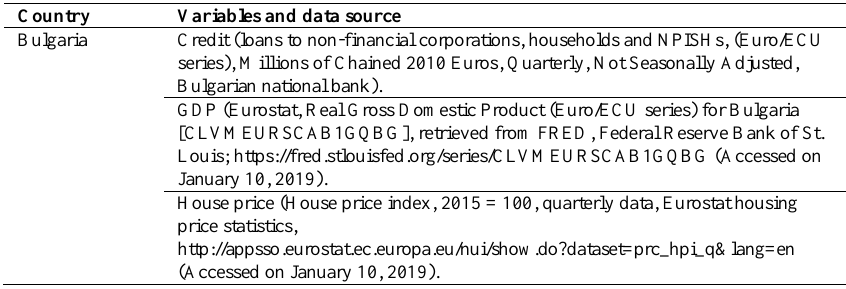
Country Variables and data source